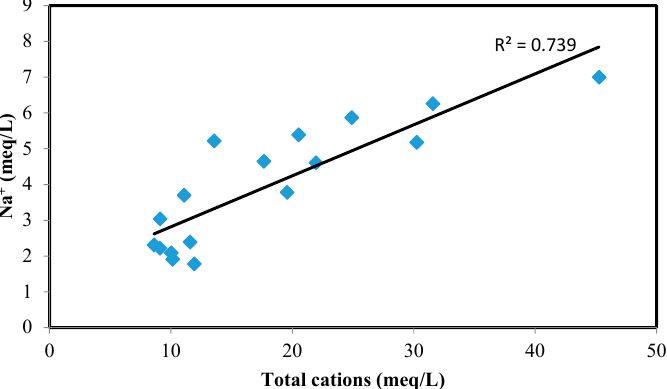
Figure 9. Na + versus total cations (meq/L) in the groundwater of the catchment.